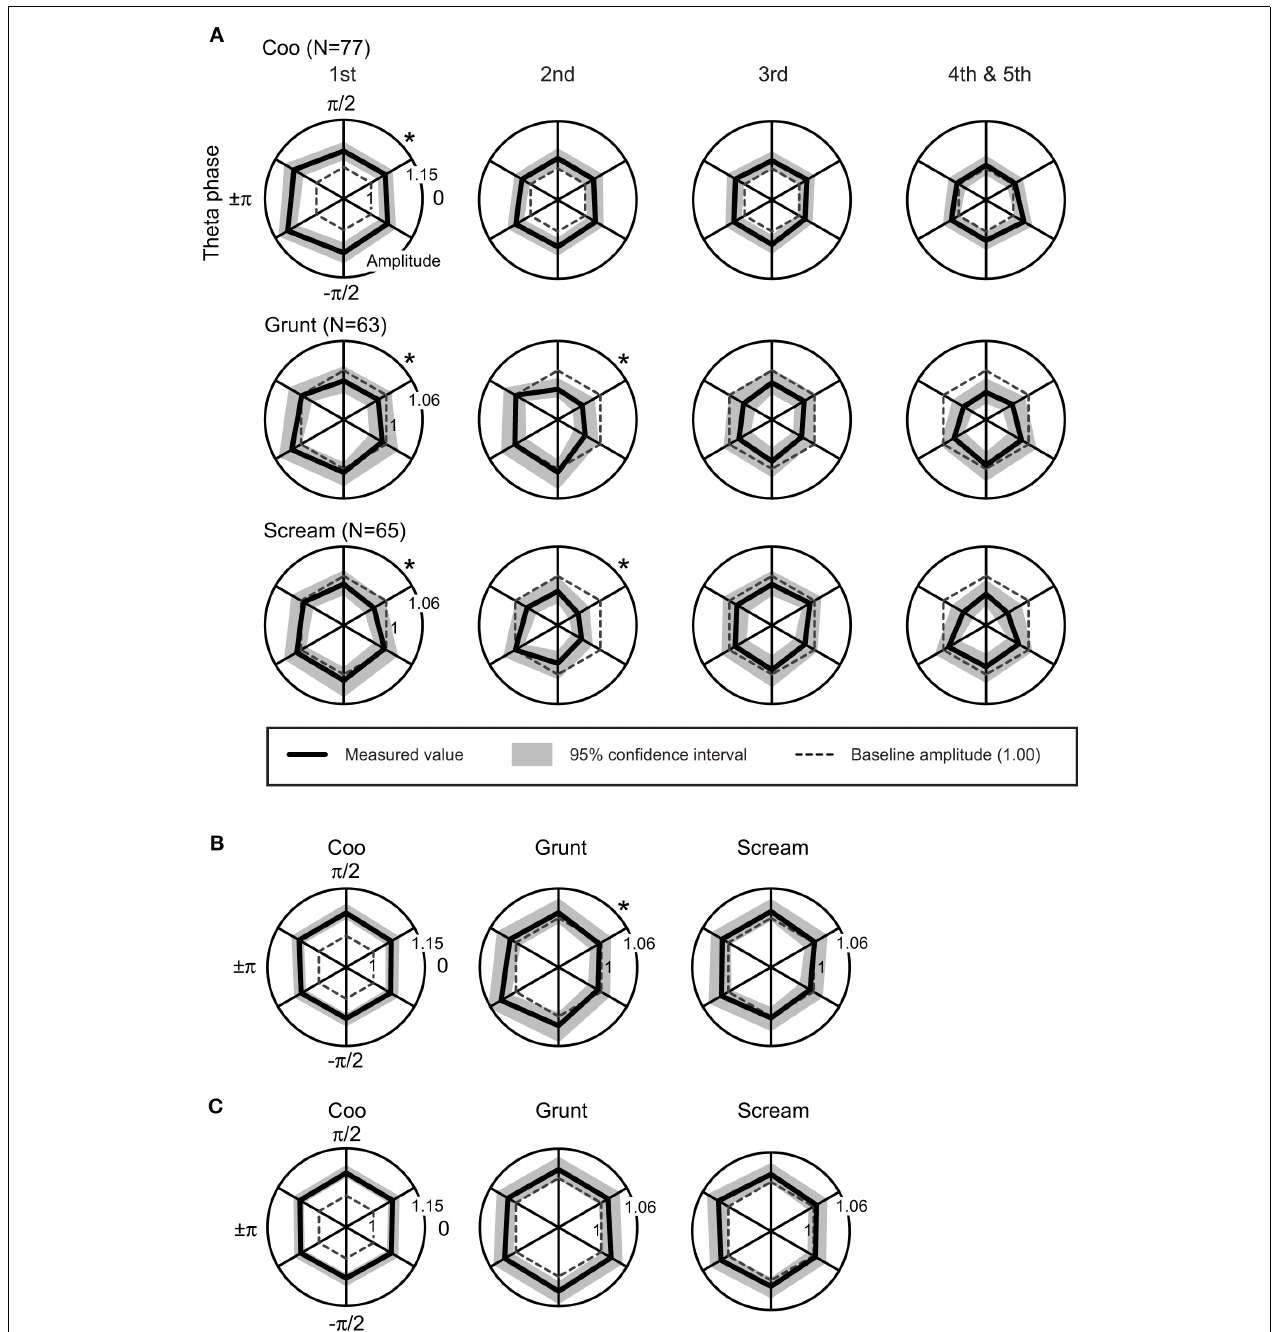
vocalization.The data in (C) show the relationship between gamma-band amplitude and beta phase during the first presentation of each vocalization. For all the plots in all three panels, the solid black line shows the mean gamma-amplitude distribution; the gray area surrounding the black line indicates the 95% confidence interval of this mean distribution; and the dotted line illustrates normalized amplitude is equal to 1. Asterisks indicate when the gamma-band amplitude is reliably different as a function of the theta phase at p <